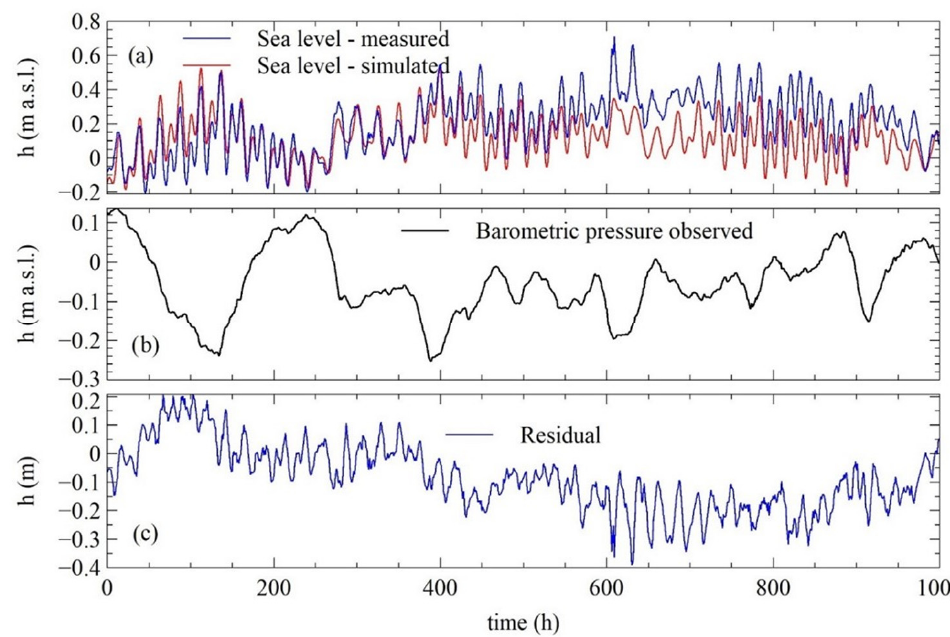
Figure 10. ( a ) Observed and simulated sea level by Equation (4) for the first 1000 h of observed sea level signals, ( b ) Observed barometric pressure, ( c ) Residual between simulated and observed sea level signals. Table 3. Pearson coefficient and root mean square values obtained between the measured and simulated sea water elevation by Equation (4).